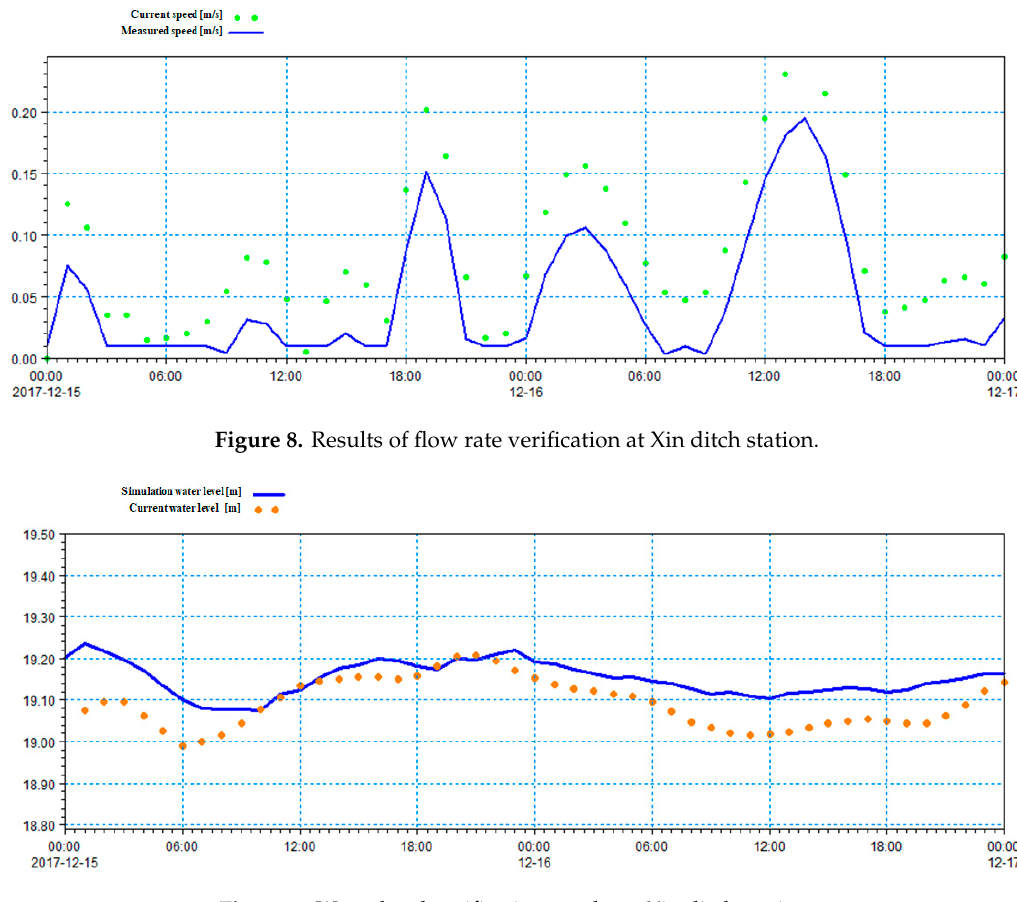
Figure 9. Water level verification results at Xin ditch station.